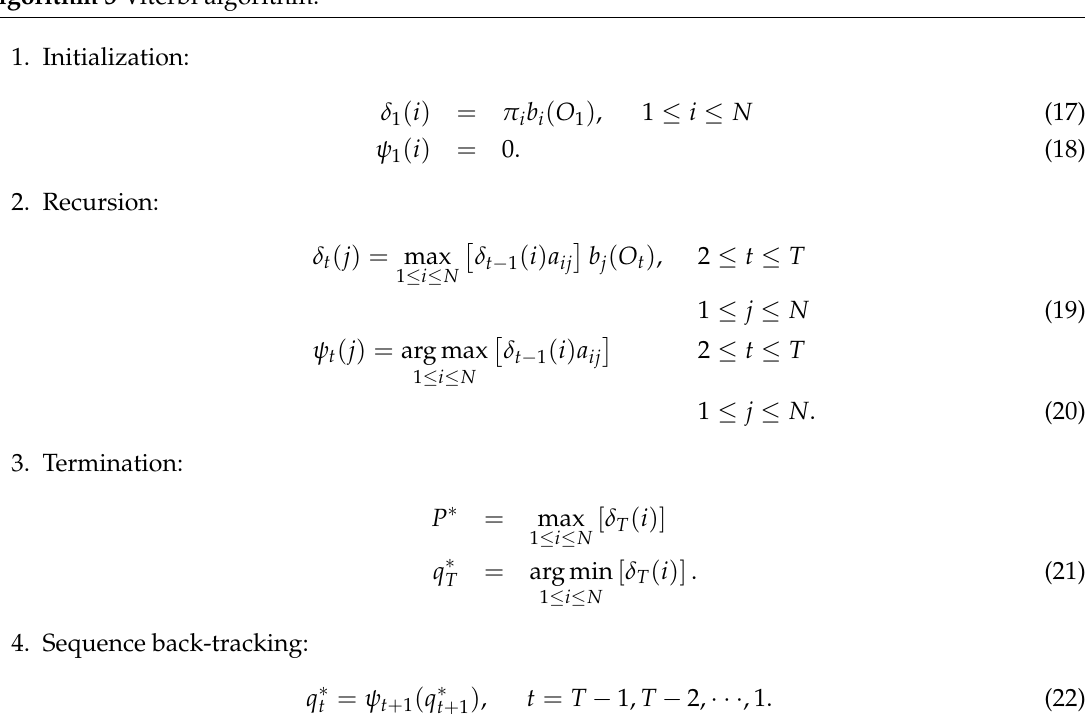
Algorithm 3 Viterbi